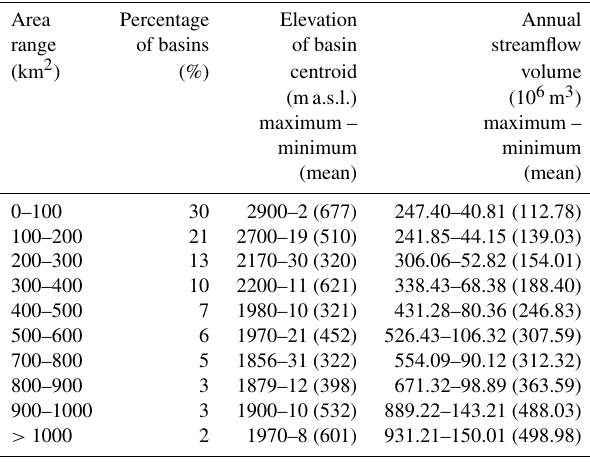
Table 1. Overall characteristics of the examined